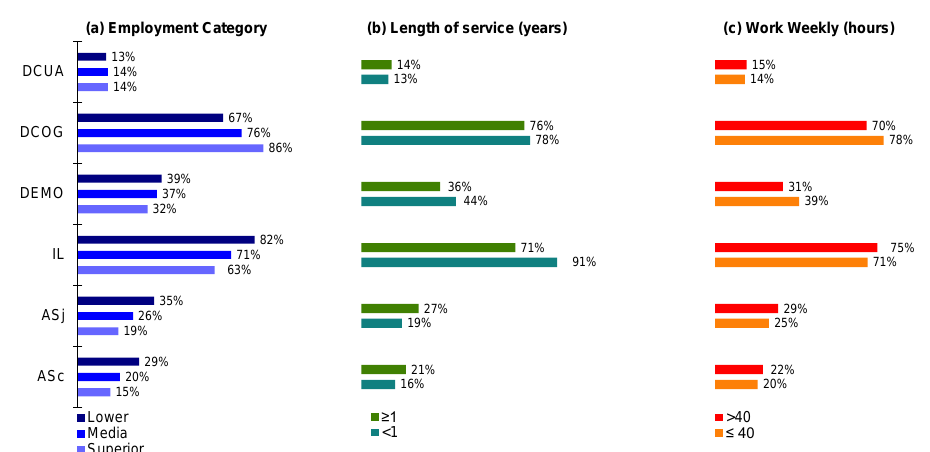
Figure 3. Psychosocial risk factors by employment characteristics ( n = 1049). ASc = social support from colleagues (% answered No), ASj = social support from bosses (% answered No), IL = job insecurity (% answered Yes), DEMO = emotional demand (% answered Yes / Partly), DCOG = cognitive demand (% answered Yes / Partly), DCUA = quantitative demand (% answered No / Partly).